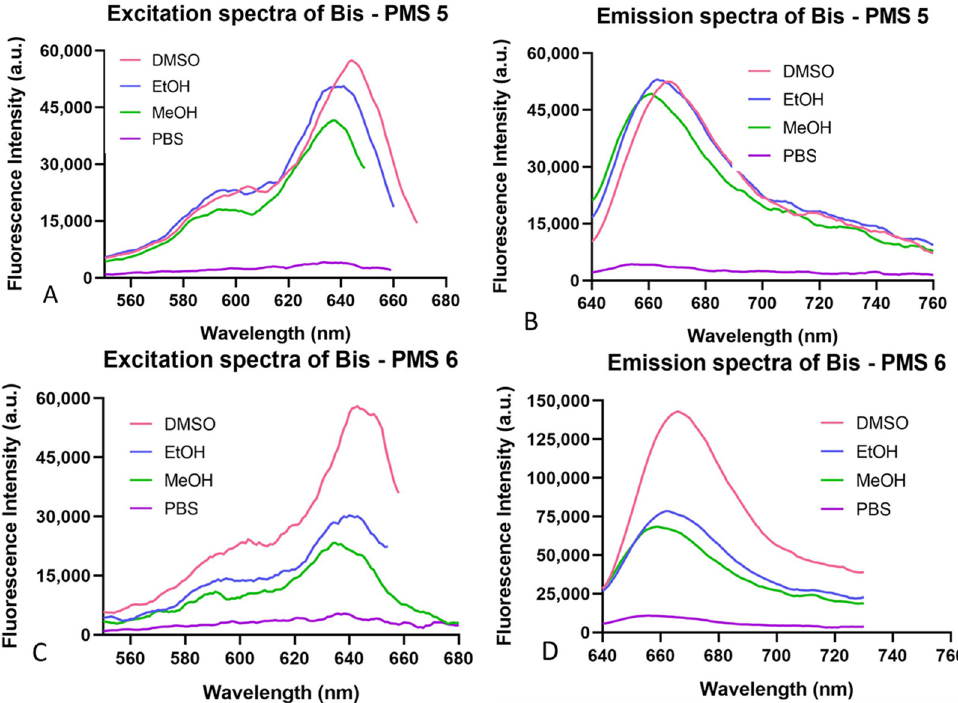
Figure 2. Excitation ( A , C ) and emission ( B , D ) spectra of Bis-PMSs 5 and 6 in four different solvents (DMSO, EtOH, MeOH and phosphate-buffered saline).